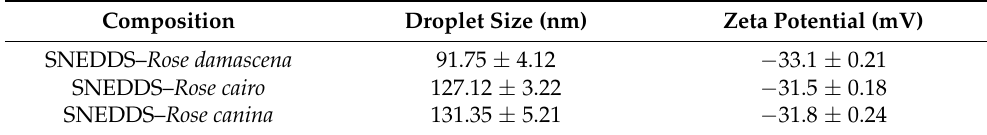
Table 2. Droplet size and zeta potential values of the formulated SNEDDS.